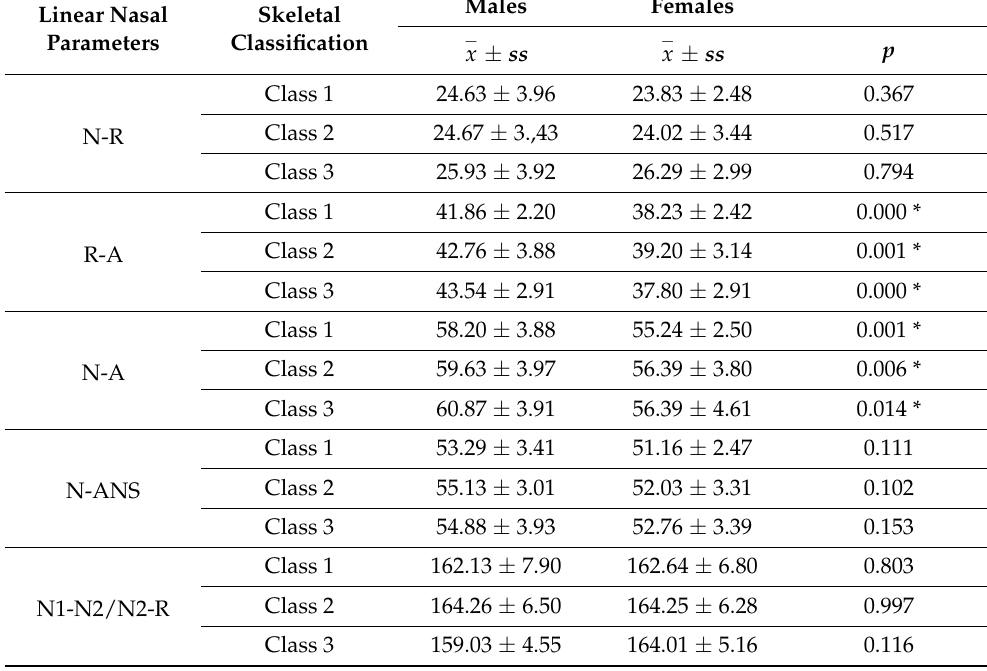
Table 6. Comparison of the nasal-related parameters between genders within the skeletal